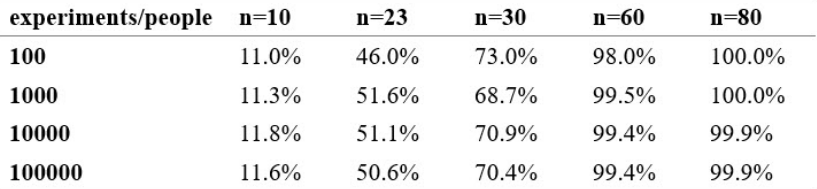
Results of randomly selected groups of people who matched